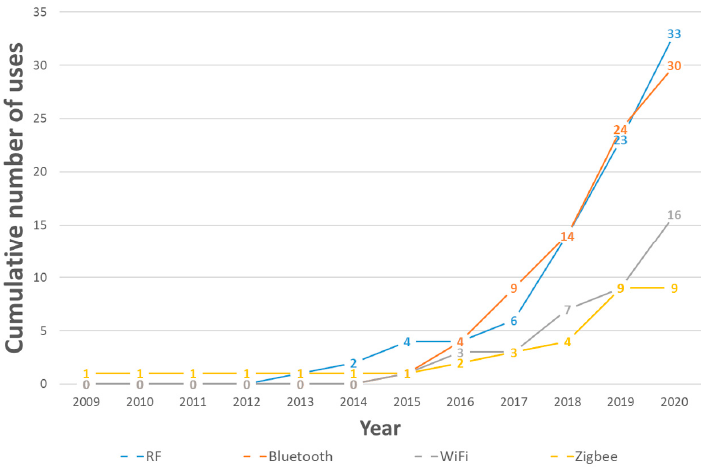
Figure 10. Cumulative number of wireless communication technologies used in smart helmet studies by year.